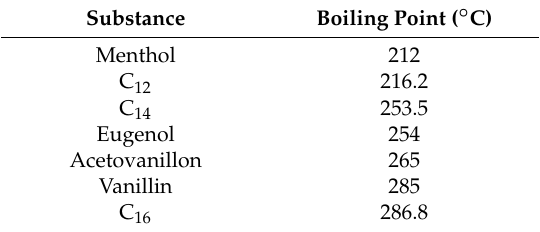
Table 5. Boiling points of the aromatic compounds and n-alkanes in the same elution range. Substance Boiling Point ( ◦ C)